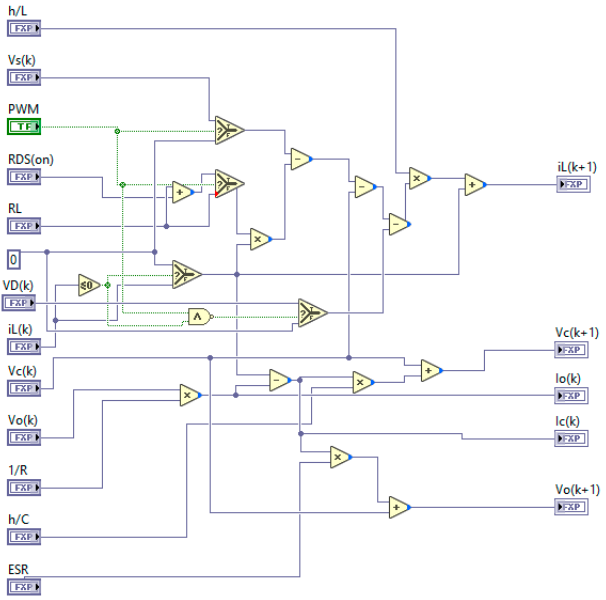
Figure 5. Discrete buck converter model programming in LabVIEW.